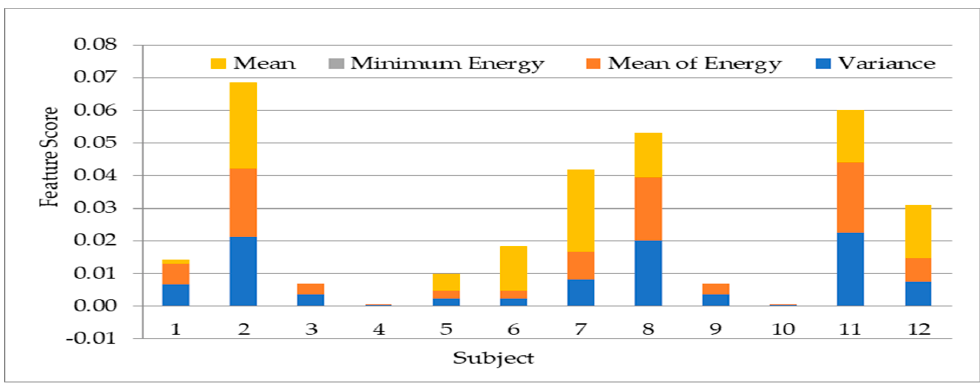
Figure 8. Variation of mean, minimum energy, mean of energy and variance on twelve subjects.